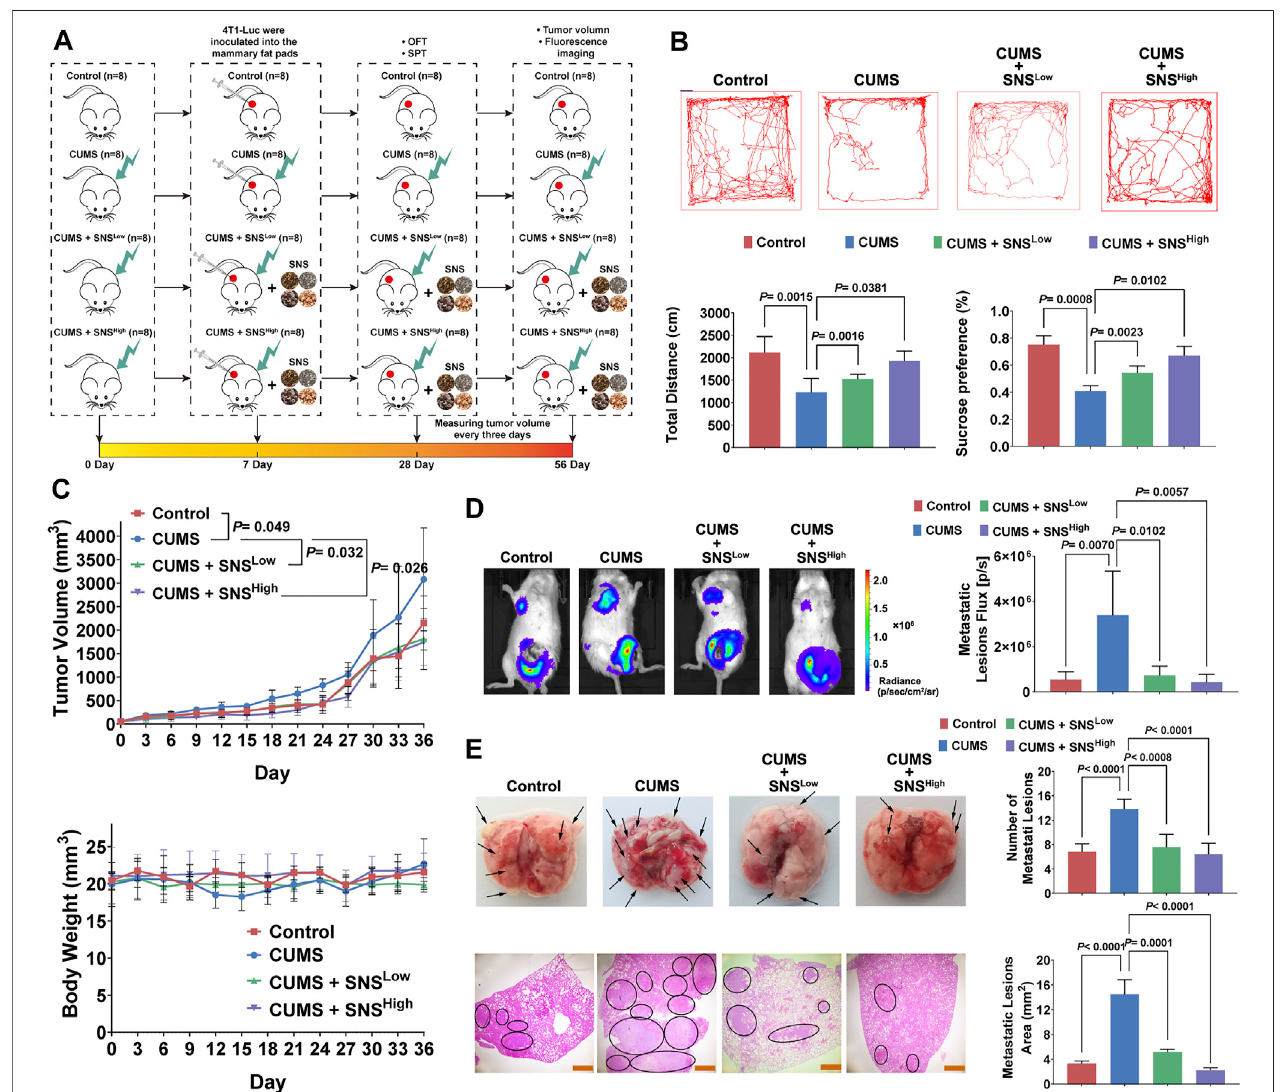
FIGURE 1 | SNS inhibits CUMS-mediated lung metastasis of breast cancer in 4T1 tumor-bearing mice. (A) Flowchart of the experiment (SNS Low , 0.825 g/kg; SNS High ,1.65 g/kg). (B) The representative movement trajectory of the mice (n (cid:2) 8, upper panel), as well as the total distance, and percentage of sucrose water consumed (lower panel). (C) Tumor growth curves(upper panel) and body weightchanges (lower panel) of the 4T1tumor-bearing mice with different treatments (n (cid:2) 8). (D) Invivo imagingoflungmetastaticlesionsinthe4T1tumor-bearingmicewithdifferenttreatments(leftpanel).Theintensityofbioluminescencewasquanti fi edby an IVIS-spectrum system (n (cid:2) 8, right panel). (E) Representative pictures of gross lung metastatic lesions in the 4T1 tumor-bearing mice with different treatments. The number of metastatic lesions was quanti fi ed (n (cid:2) 8, upper panel). HE staining of the lung metastatic lesions in the 4T1 tumor-bearing mice with different treatments. The black circle indicates the metastatic lesions of the lung. The scale bars indicate 1000 μ m. The metastatic lesion area was quanti fi ed by ImageJ software (n (cid:2) 8, lower panel).Dataarerepresentedasthemeanvalue ± SD.One-wayANOVAandBonferroni ’ sposthoctestwereapplied.ANOVAforrepeatedmeasurementswasperformed in (C)